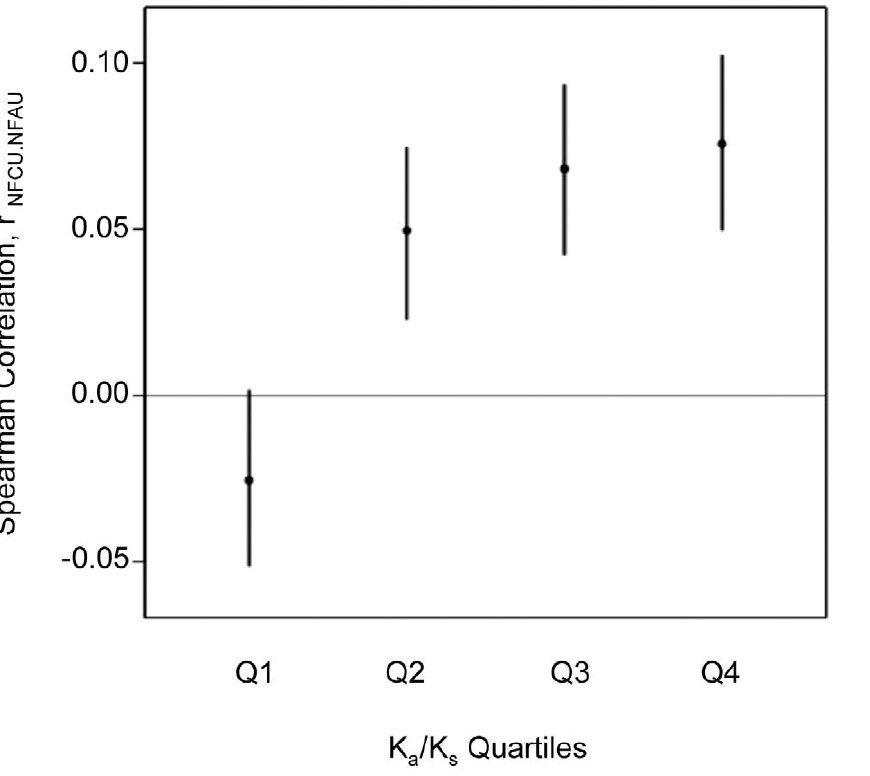
Figure 2. The genome-wide correlation between transcriptional robustness strategies depends on selective constraint. Pairwise correlation between normalized fragile codon usage (NFCU) and normalized fragile amino-acid usage (NFAU) for 17421 human genes with an ortholog in mouse. Human genes were binned by selective constraint (K a /K s ) estimated using the pairwise alignment with their mouse ortholog and for each quartile of K a /K s (Q1, lowest, to Q4, highest), Spearman’s correlation between normalized fragile codon usage and normalized fragile amino- acid usage (r NFCU.NFAU ) was calculated. The vertical extent of the bar indicates the 95% confidence interval for each correlation.